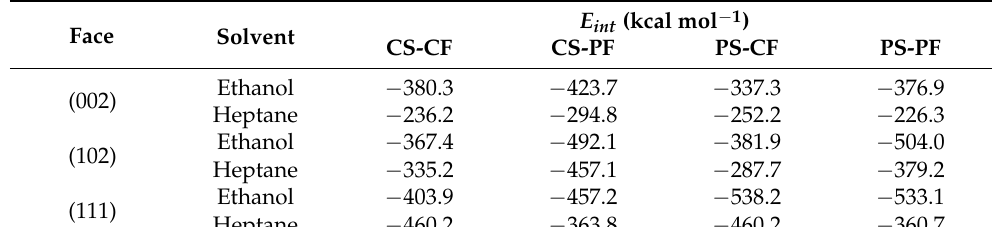
Figure 10. The binding energies E b (kcal mol −1 ) between the crystal layer and solution layer of the (002), (102), and (111) crystal face in different models.